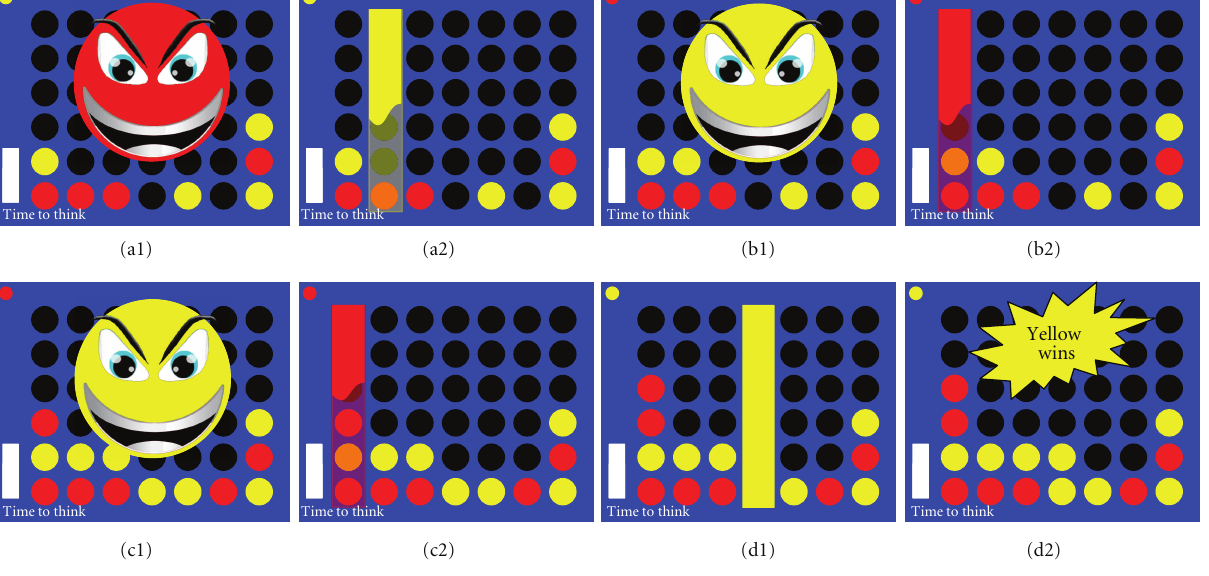
Figure 6: Second game in contest mode. Yellow won by connecting four coins horizontally. For the purpose of illustration, yellow and red rectangles are made partially transparent to make all coins